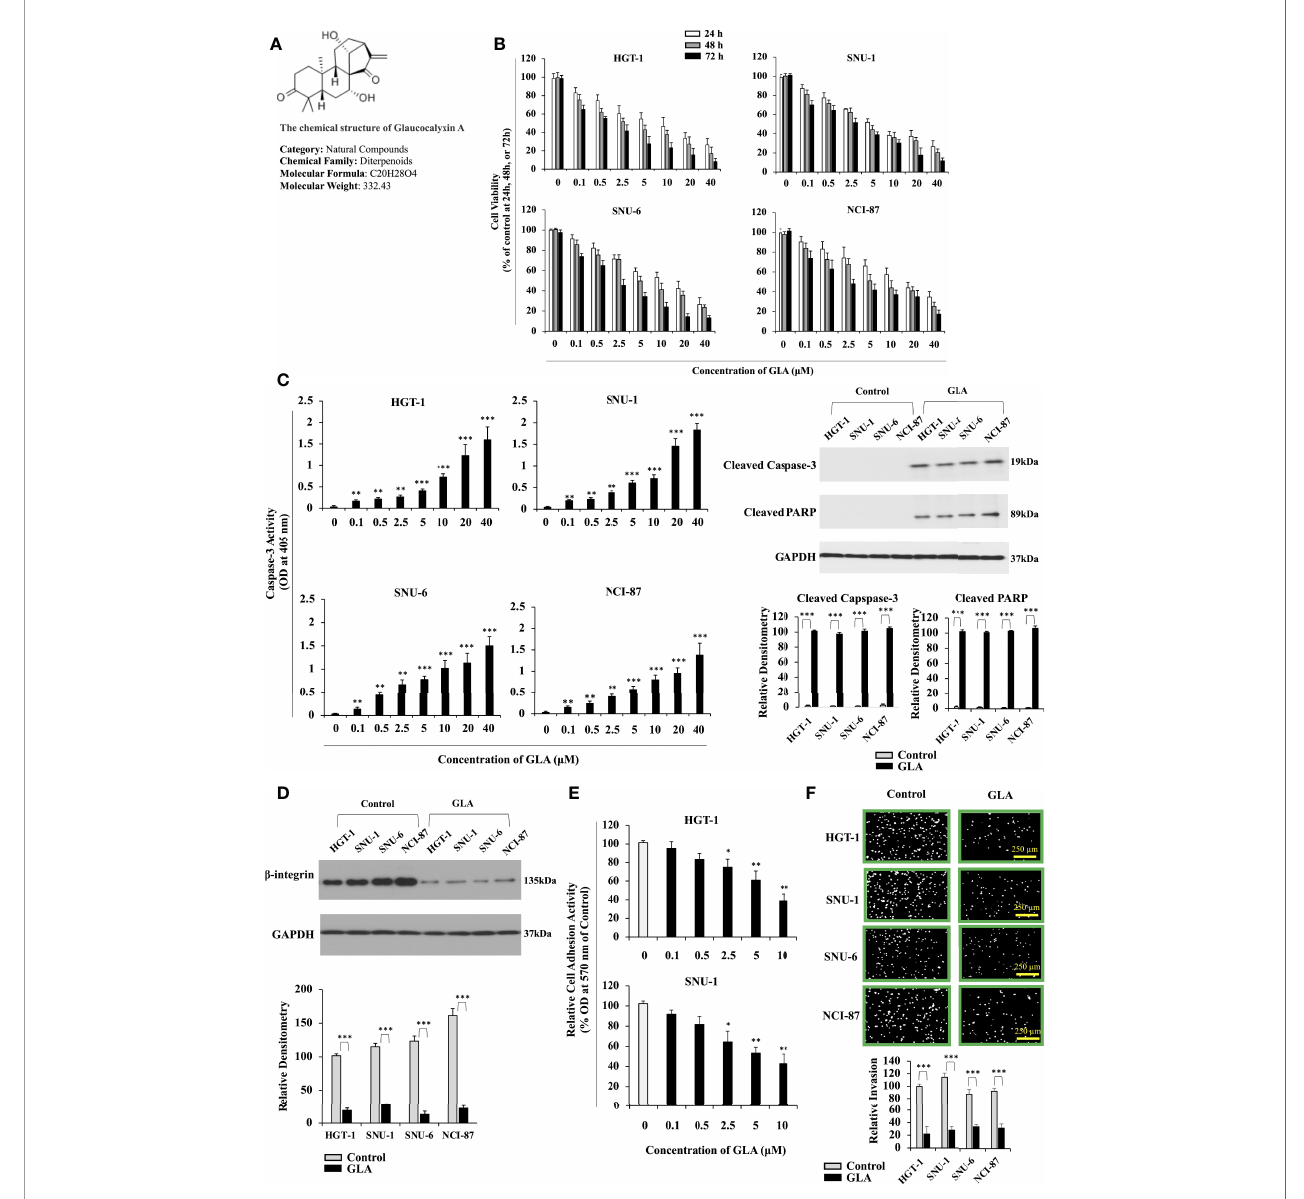
FIGURE 1 | Inhibition of the malignant behavior of GC cells by GLA. (A) Chemical structure of GLA. (B) Changes in cell viability of HGT-1, SNU-1, SNU-6, and NCI-N87 GC cell lines treated with 0, 0.1, 0.5, 2.5, 5, 10, 20, and 40 µM of GLA at 24 h, 48 h, or 72h (% of control). (C) The caspase-3 activity was shown as OD values at 405 nm in HGT-1, SNU-1, SNU-6, and NCI-N87 treated with the indicated concentrations of GLA (left panel). Western blot analysis of cleaved caspase-3 and cleaved PARP in HGT-1, SNU-1, SNU-6, and NCI-N87 cells in the presence of 10 µM of GLA (right panel). GAPDH served as an internal control. (D) Western blot analysis of b -integrin in HGT-1, SNU-1, SNU-6, and NCI-N87 cells in the presence of 10 µM of GLA. (E) Cell adhesion activity shown as OD values at 570 nm in HGT-1 and SNU-1 cells in the presence of 0, 0.1, 0.5, 2.5, 5, or 10 µM of GLA for 90 min. (F) Invasion of HGT-1, SNU-1, SNU-6, and NCI-N87 cells treated with 10 µM of GLA of for 12 h (100 × magni fi cation; scale bar-250 µm). The Western blot analysis was repeated three times. The data represented the mean ± SD (n=3). * p < 0.05, ** p < 0.01, *** p